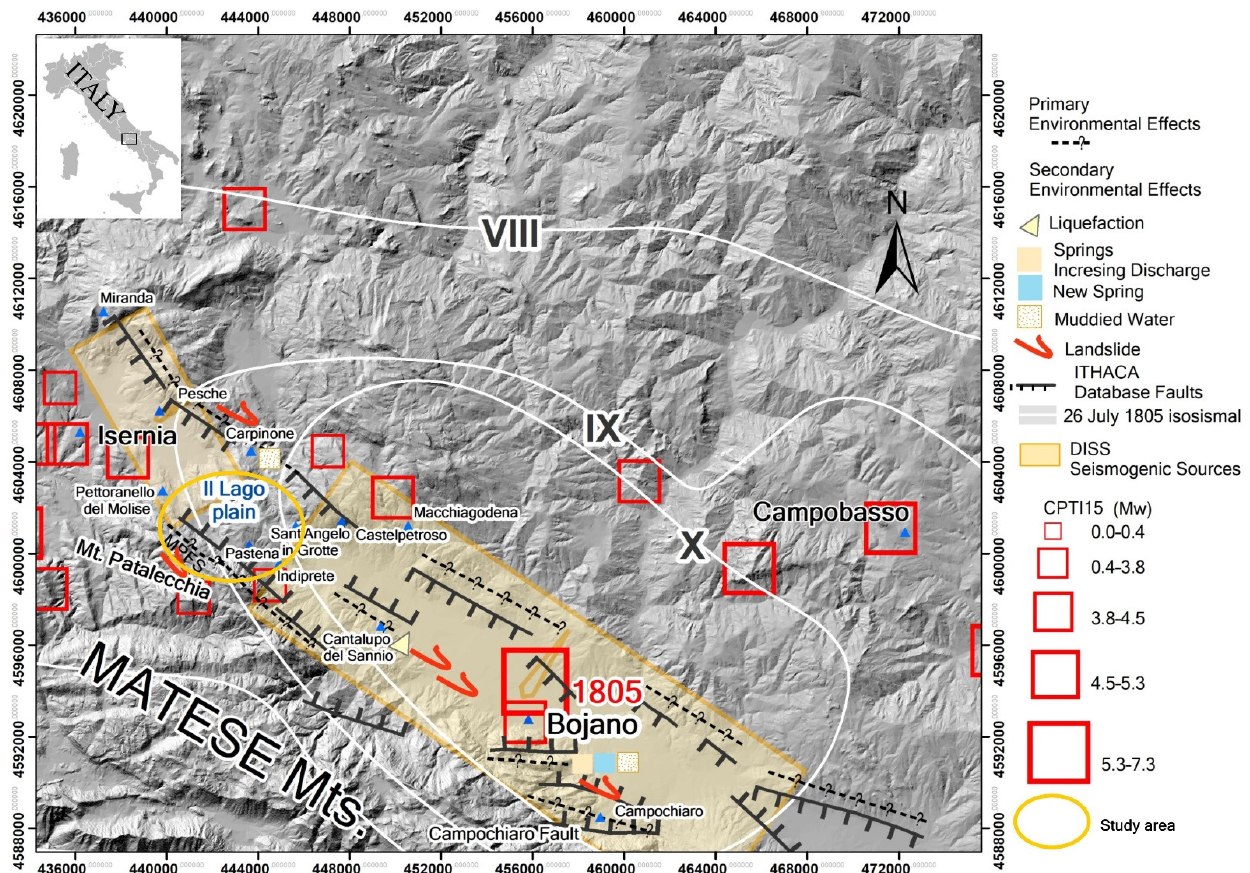
Figure 1. Seismotectonic sketch map of the study region: the study site of “Il Lago” Plain is the dark yellow ellipse; the historical earthquakes’ epicenters are from CPTI15 [24] (red squares); the Scheme 23. (orange rectangular boxes); the isoseismals (MCS intensity scale) of the 1805 earthquake are from [20] (white solid lines); the primary coseismic fractures of the 1805 earthquake are from [22] (black dashed lines); the secondary coseismic effects of the 1805 earthquake, namely liquefaction, springs increasing discharge, new springs, muddied waters, and landslides, are from [22]. Easting and northing are UTM WGS 84.